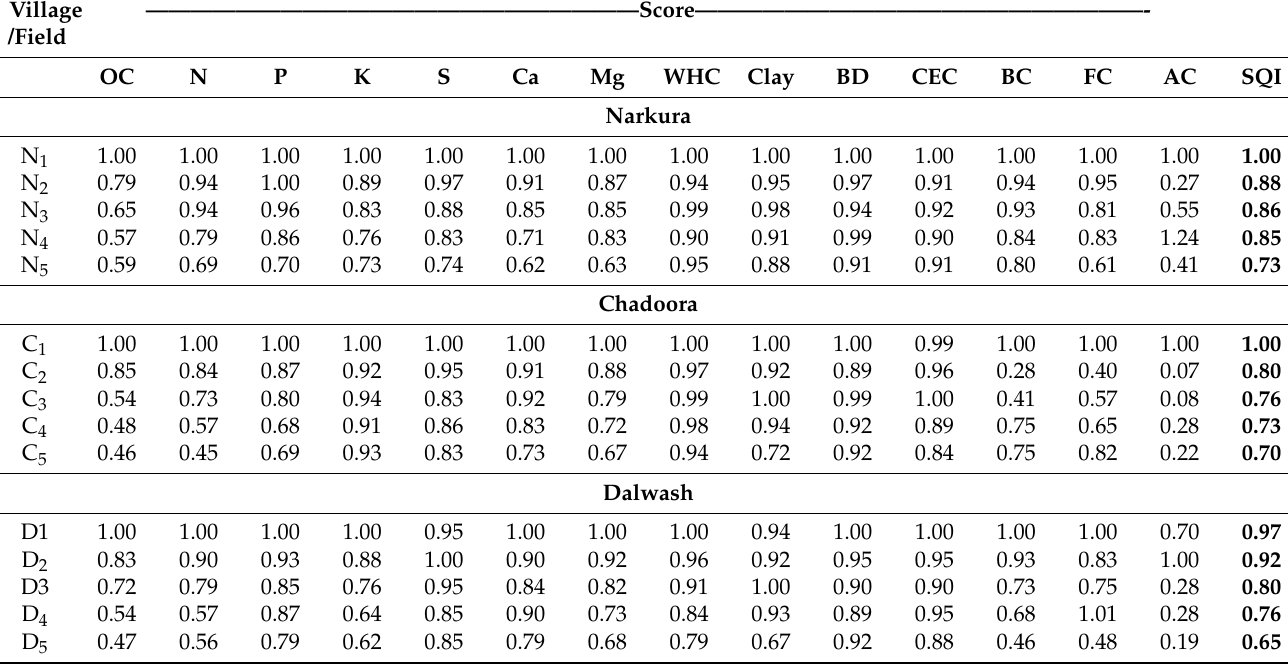
Table 4. Linear Scores of soil quality indicators and soil quality indices of various fields in the